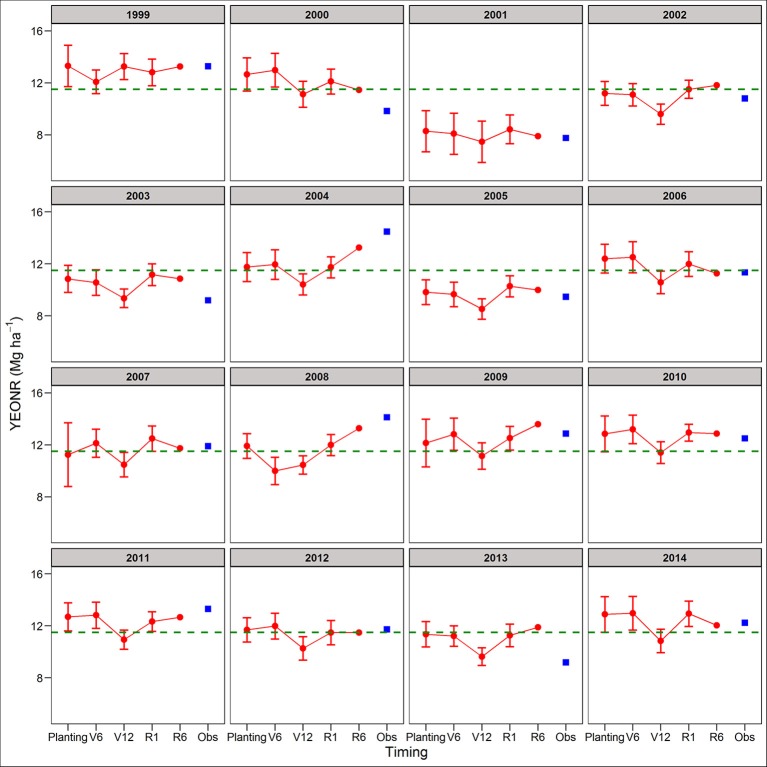
Predicted and observed yield at the economic optimum N rate (YEONR) for continuous corn. The connected red dots indicate APSIM model predictions at planting time, V6 (6th leaf), V12 (12th leaf), and R1 (silking) stages using actual and historical weather data (vertical bars indicate standard deviation, n = 35). At maturity (R6), the weather is known so there is no uncertainty in yield prediction. Blue squares represent the observed YEONR. The green dashed line represents the mean YEONR for the study period at this site.